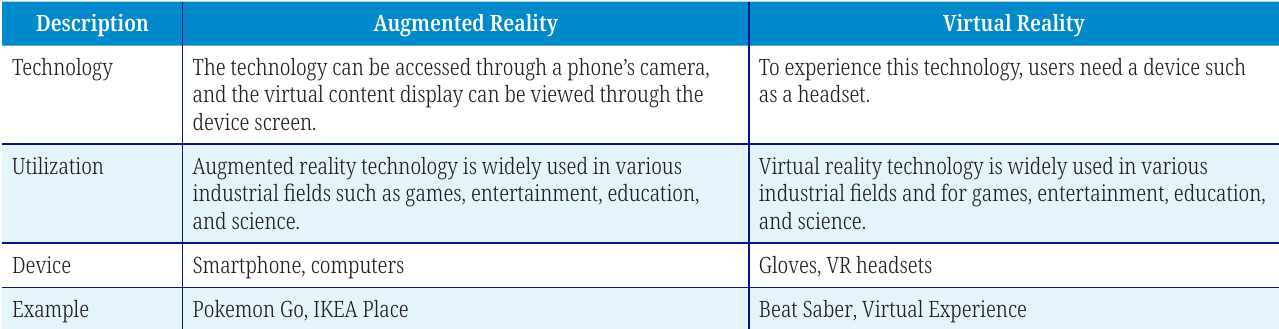
Table 7. Similarities and differences between AR and VR